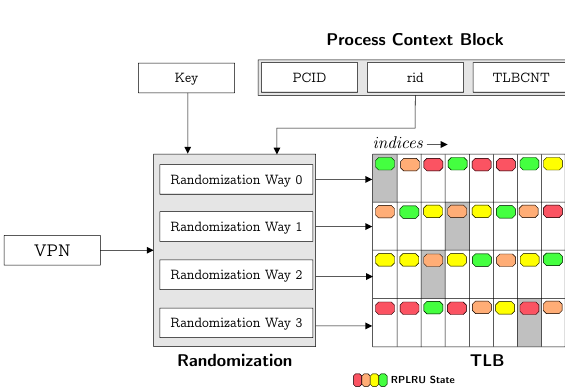
Figure 2: An example of TLBcoat showing the added randomization module. The randomization is done for every way, which may require multiple parallel instantiations of the randomization